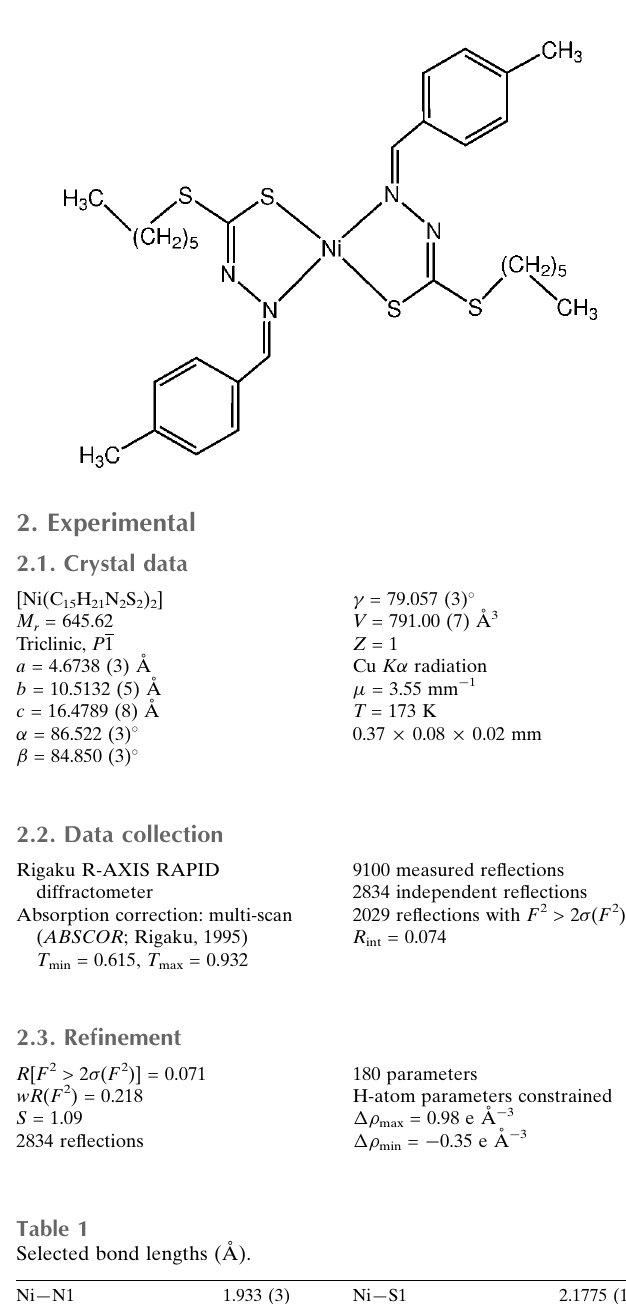
Selected bond lengths (A˚